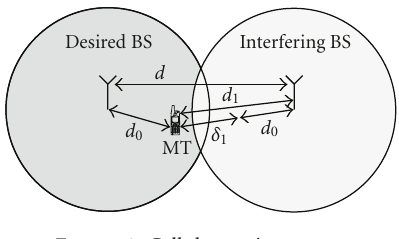
Figure 3: Cellular